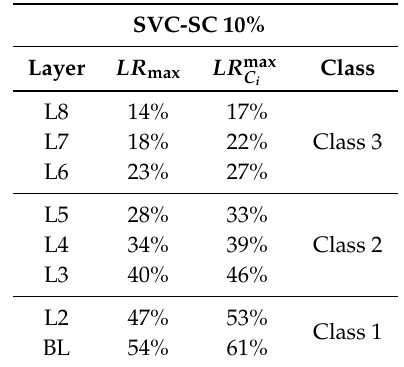
SVC-SC allocation per layer, C i